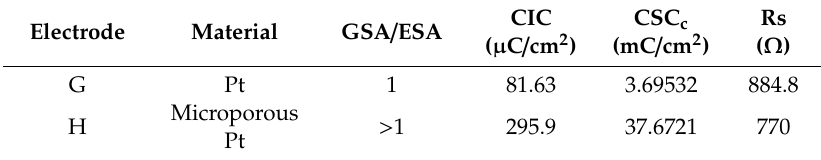
Table 3. Characteristic values of Pt cu ff electrodes G and H with the same shape and size, but di ff erent